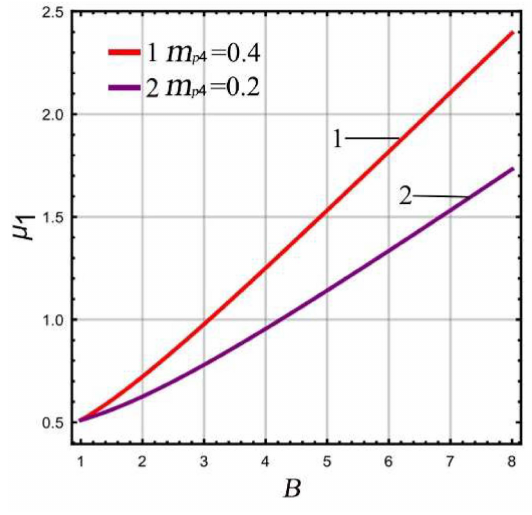
Figure 4. The relationship between µ 1 and B.